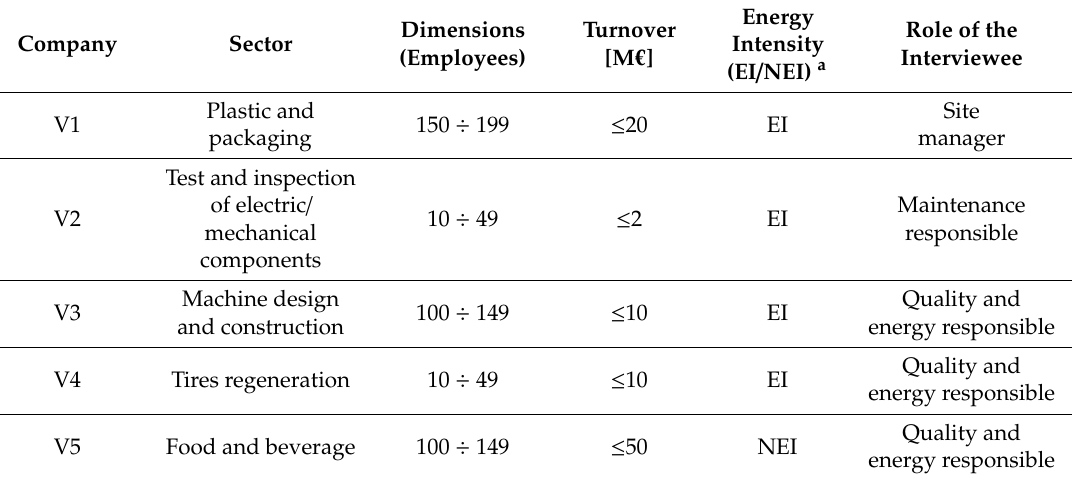
Table 5. Heterogeneity of the sample for the framework empirical